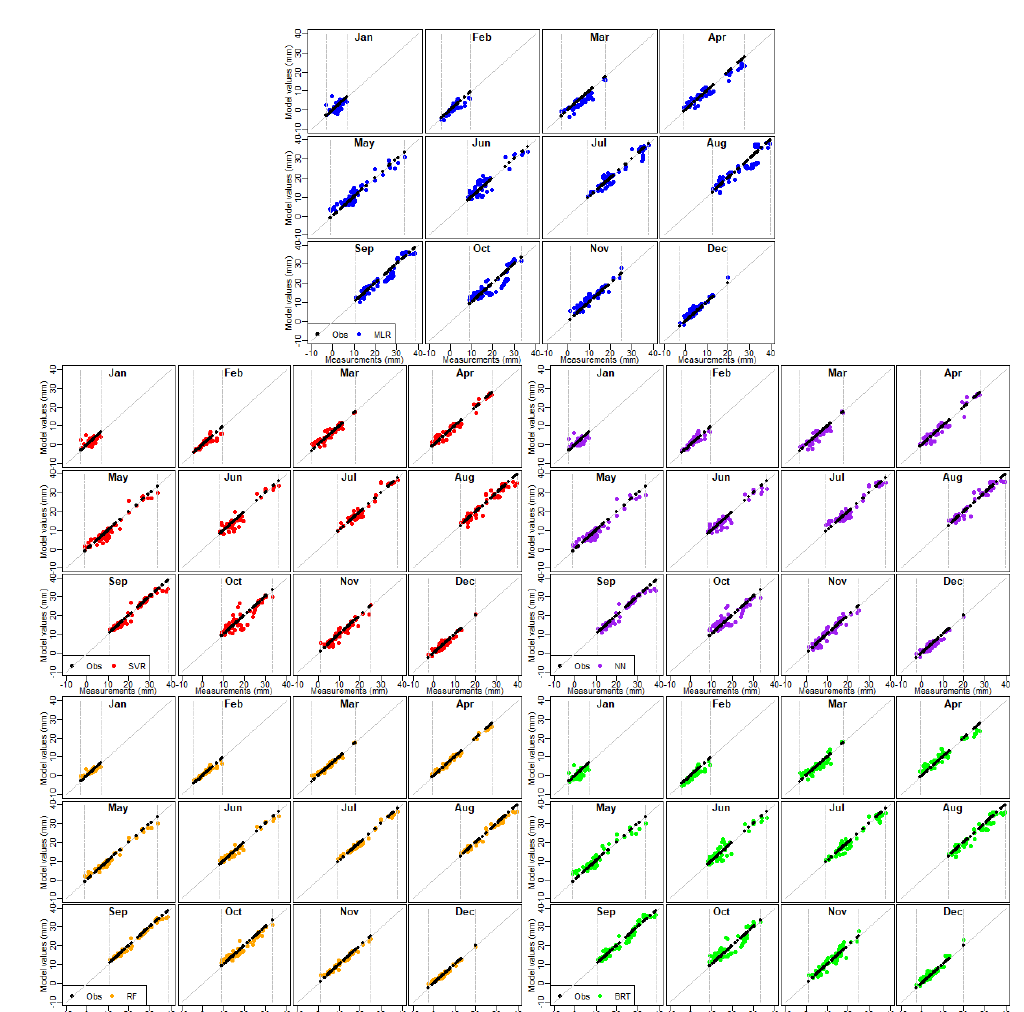
Figure 15. ML model values vs measurements of radial displacements in FP5/5–277.07 m from 2000 to 2014 (training data). The vertical lines are the maximum and minimum measured values obtained during the training